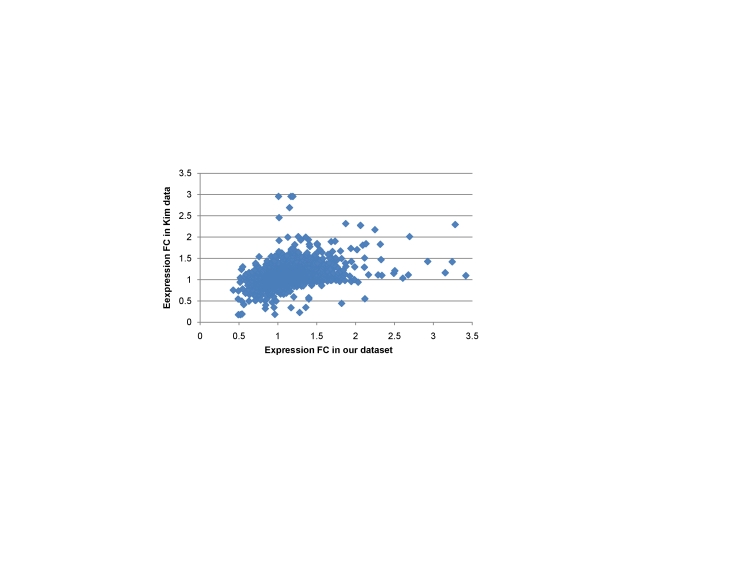
Distribution of expression differentials between out data and Kim dataset.